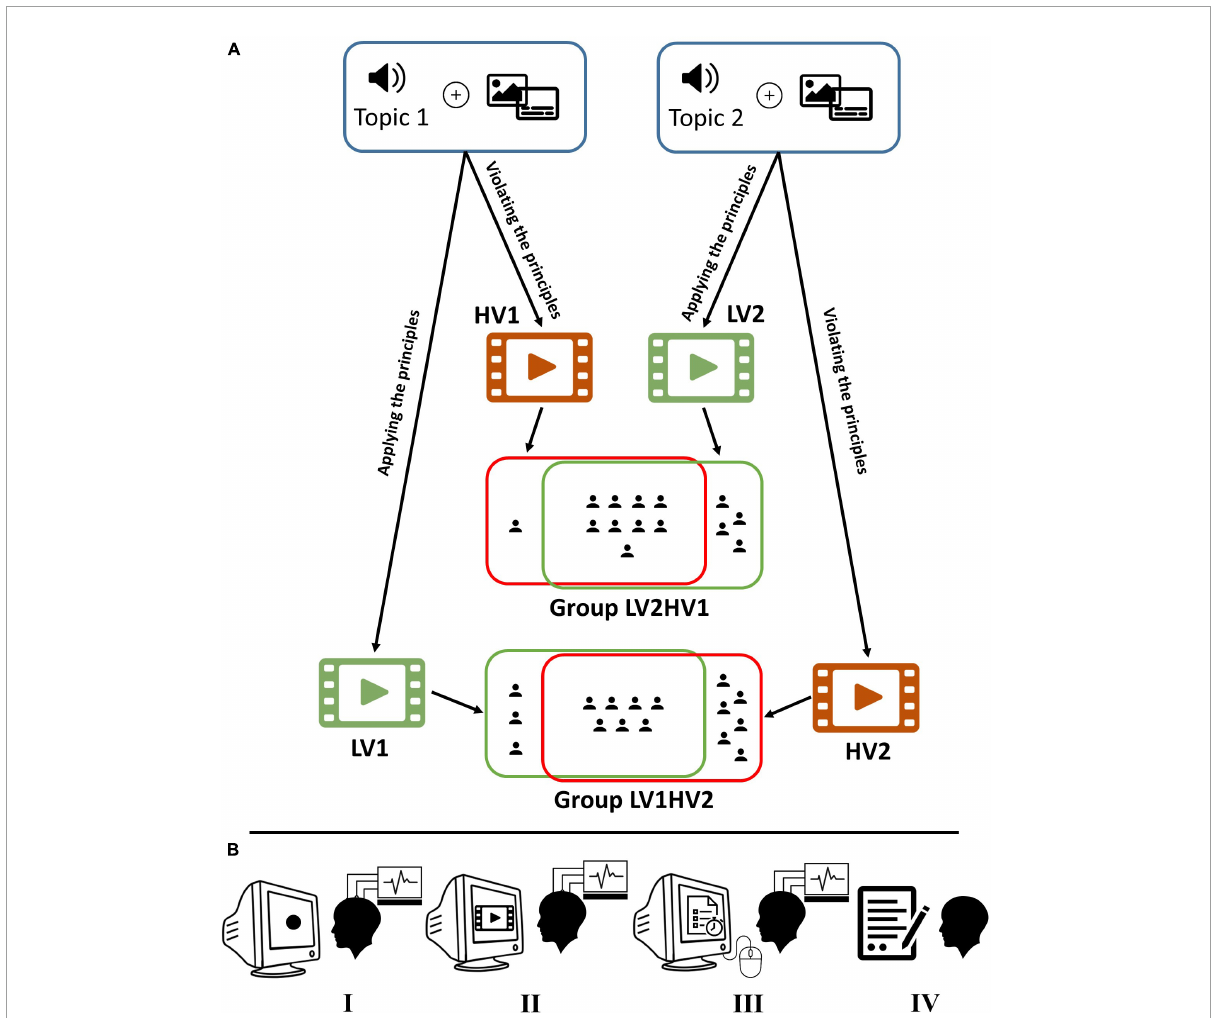
FIGURE1 Experiment design. (A) Based on two audio narrations, four versions of videos (two for each narration) were created: LV1 (HV1) and LV2 (HV2) by applying (violating) the principles of multimedia design. Low load and high load video identified by green and red, respectively. Participants are randomly divided into two groups: LV1HV2 and LV2HV1. In our experiment, the LV1HV2 (LV2HV1) watched LV1 (LV2) and HV2 (HV1) videos in two separate sessions. As illustrated in the figure, in each group, some subjects participated only in one session. (B) The procedure of the experiment (left to right): first, looking at a black-filled circle for recording baseline data; second, watching the multimedia (no interaction); third, taking part in the recall test (via mouse interface); and finally completing the NASA-TLX questionnaire (paper-based version). In the first and second steps, electroencephalography (EEG) signals are